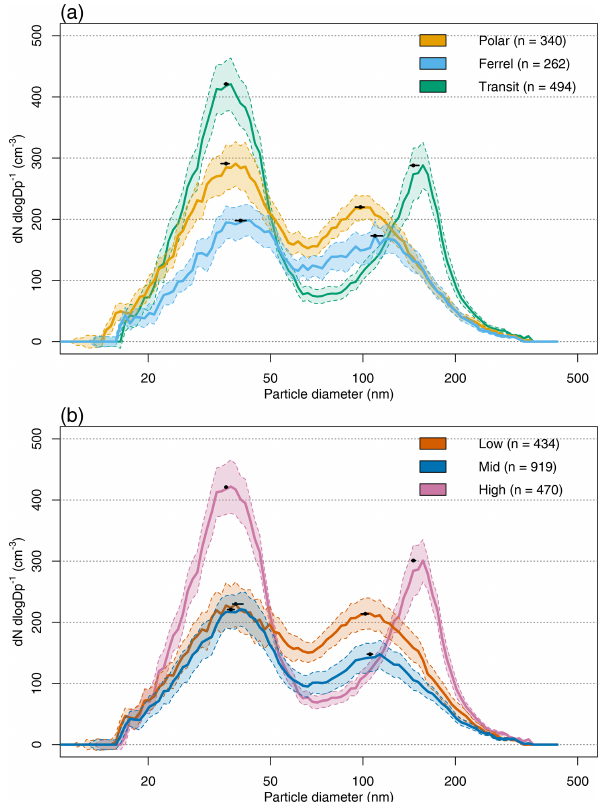
Figure 5. Median particle size distributions for (a) each wind cat- egory and (b) each AH category. Shaded areas represent the 95% confidence interval in the median for each bin size. Note the diame- ter axis is logarithmic in scale. The modal sizes and concentrations for each distribution are reported in Table S3. Black points plotted on each distribution indicate the median Aitken and accumulation mode generated from analysis of individual size distributions. Error bars represent the 95% confidence interval. More detail is provided in the Supplement Sect. S1 and Table